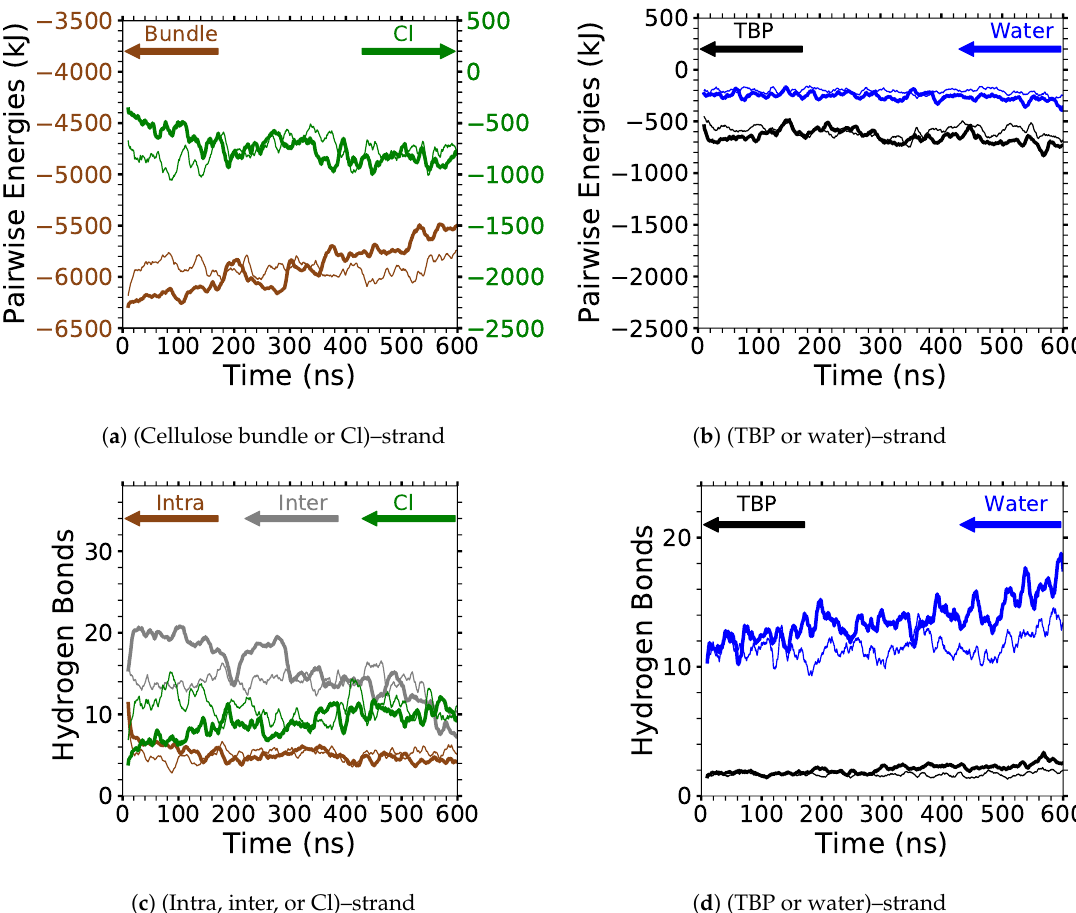
Figure A17. Pairwise energies and hydrogen bonding of the peeling strand(s) at 91.1mol%water and 360K. The pairwise energies of the separating strand(s) between the: ( a ) (cellulose bundle or Cl)–separating strand; ( b ) (TBP or water)–separating strand. The number of hydrogen bonds for the separating strand(s) per the given type: ( c ) (intra, inter, or Cl)–separating strand; ( d ) (TBP or water)–separating strand. The thick line is the first yellow strand to peel, and the thin line is the non-peeling yellow strand or second strand to peel. If neither of the stands peel, then both the thick and thin lines are non-peeling yellow strands. The data were averaged over 1000 data points, using a rolling